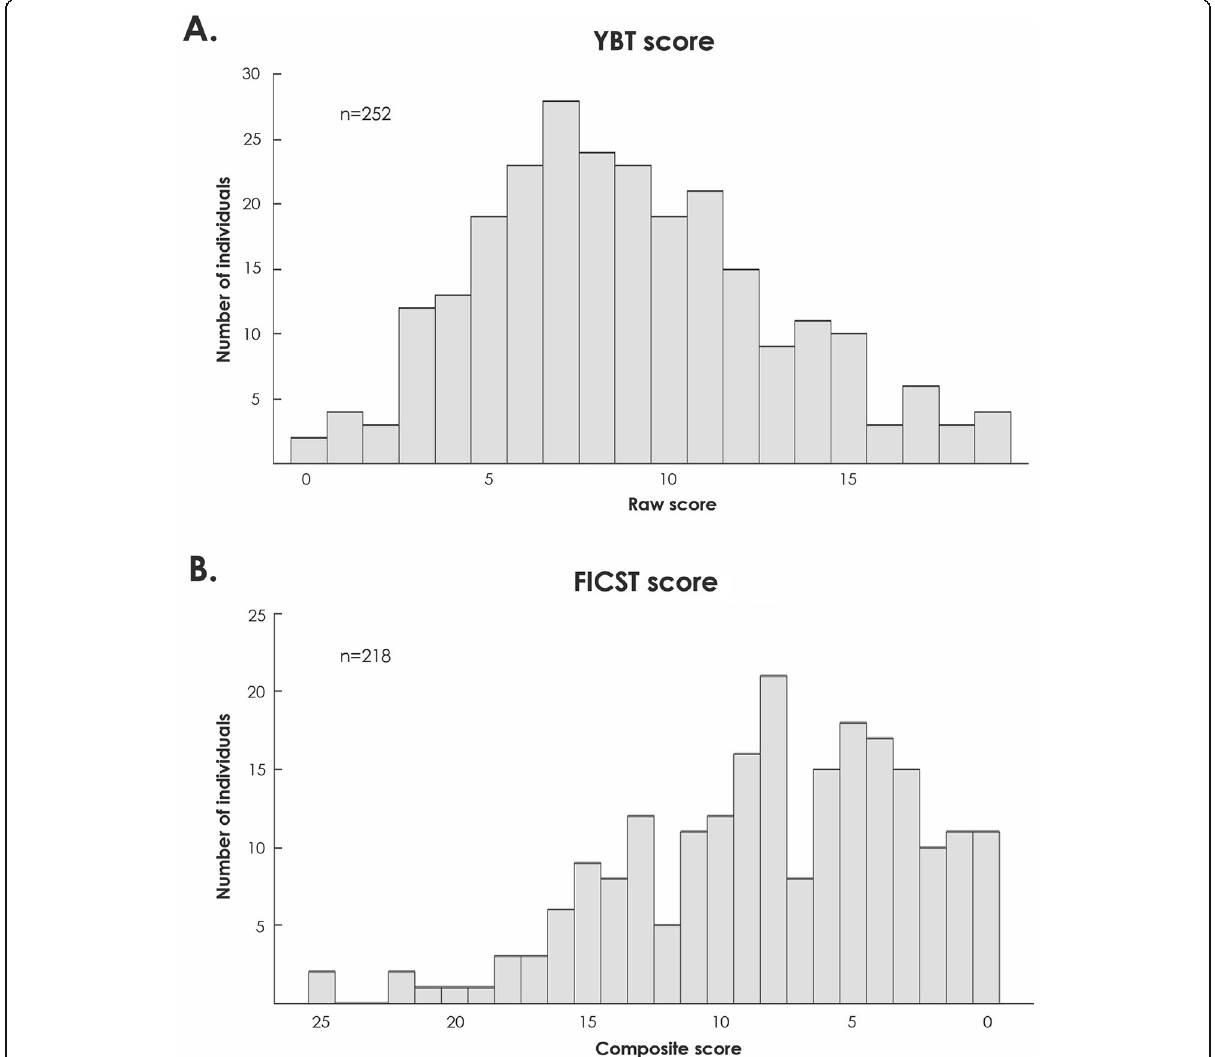
Fig. 2 Distribution of scores obtained for the a Yearbook Test (YBT) and b Facial Identity Card Sorting Test (FICST). Across both tasks, low and high scores are represented on the left and right,